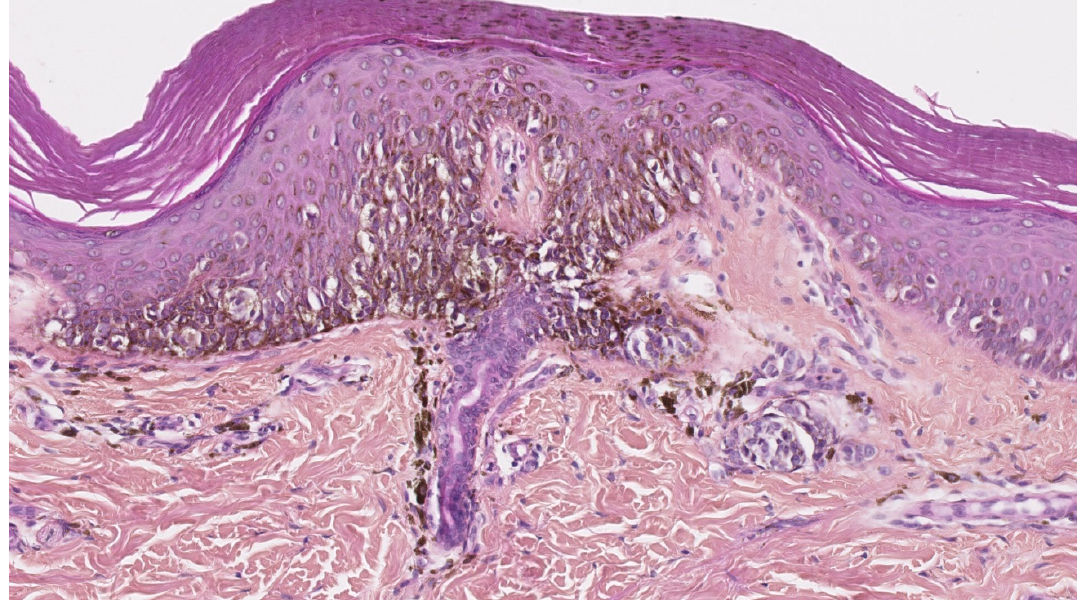
Figure 6. Junctional component of a congenital nevus in a newborn. Irregularly distributed melanocytes with pagetoid spread. HE ×250.